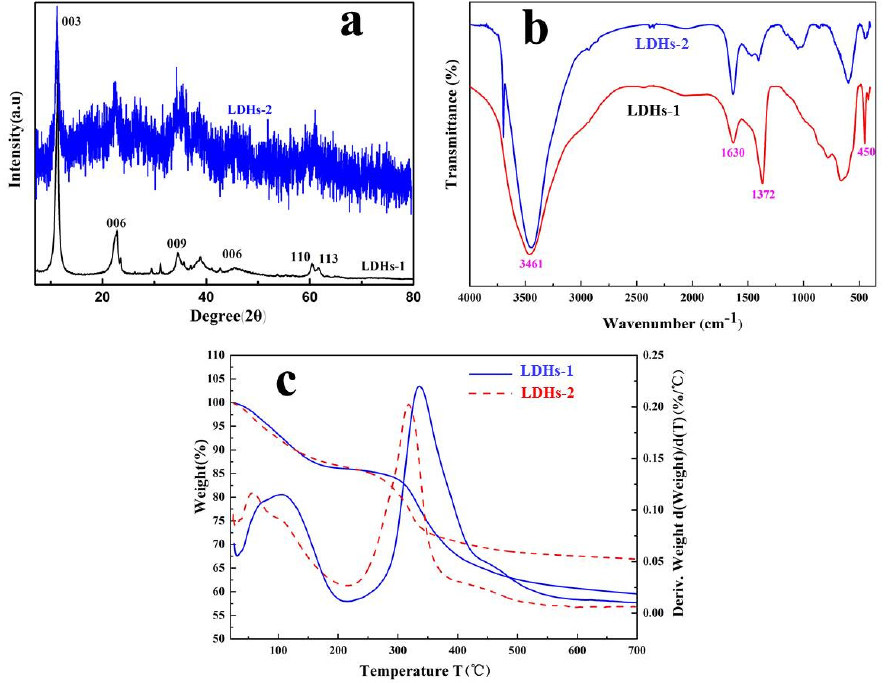
Figure 1. ( a ) XRD curves, ( b ) FT-IR spectras and ( c ) TG-DWG images of LDHs-1 and LDHs-2. The FT-IR spectra was performed to detect the functional groups between LDHs-1 and LDHs-2 layers. As shown in Figure 1b, the absorption peak located at 3461 cm − 1 was